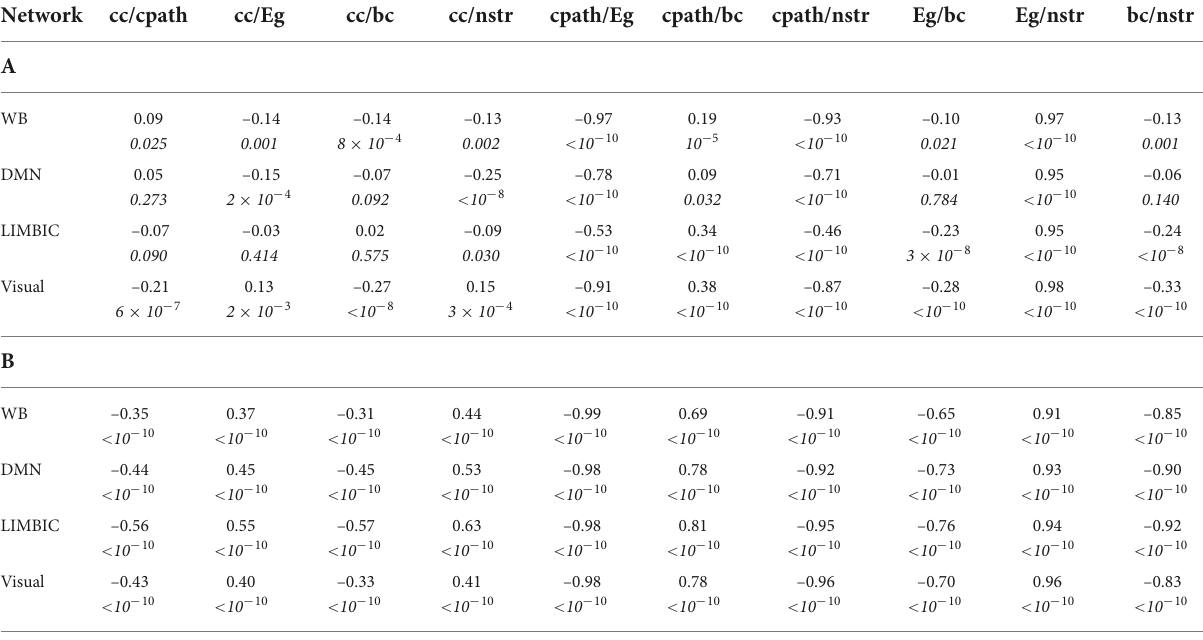
TABLE 2 Correlation coefficients and p -values (the latter in italics) for the graph theoretical metrics of the NS-weighted networks (A) and the FA-weighted networks (B). Network